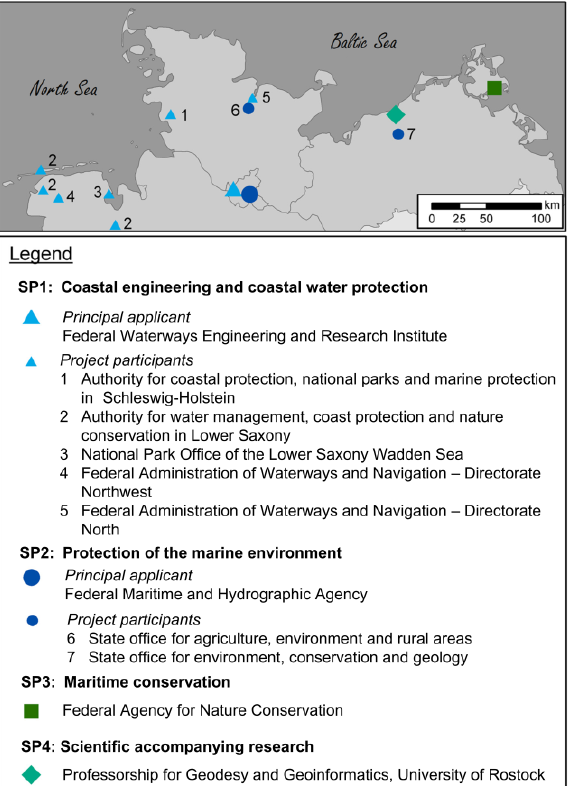
Figure 1. Project participants, sub projects (SP) and their